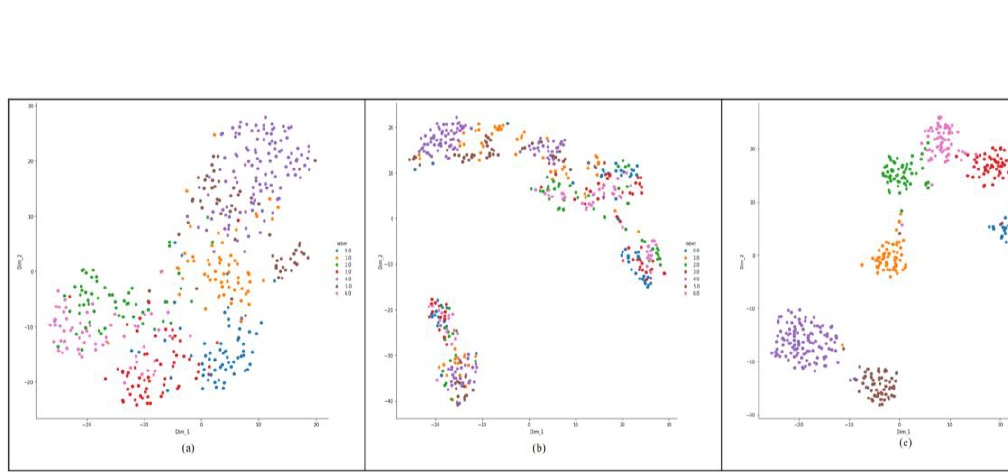
Figure 6. T-SNE plot of (a) MFCC+pitch (b) MFCC+pitch + S-LDA(k=4) (c) MFCC+pitch + S-LDA